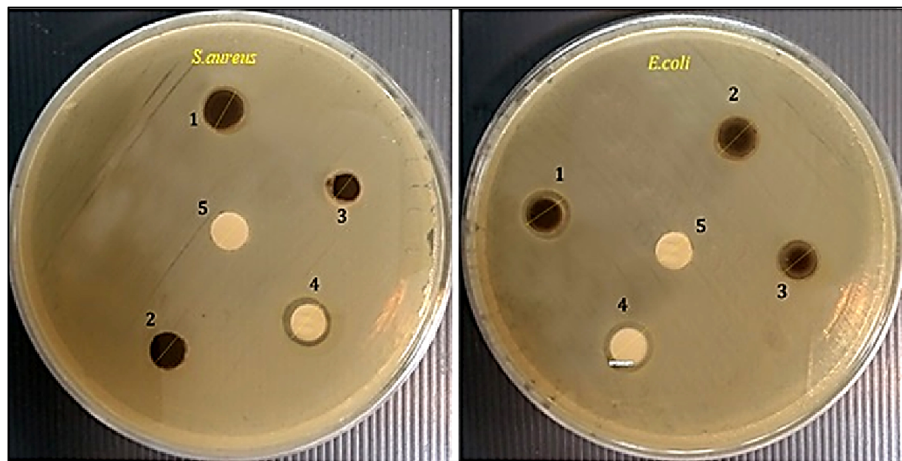
Figure 9: Disc di ff usion assay exhibiting the impact of green - synthesized NPs as antibacterial agents against S. aureus and E. coli . ( 1 ) Green synthesized ( N. sativa - iron oxide ) NPs, ( 2 ) IONPs, ( 3 ) N. sativa extract, ( 4 ) erythromycin ( C + ve ) , and ( 5 ) DW ( C − ve )